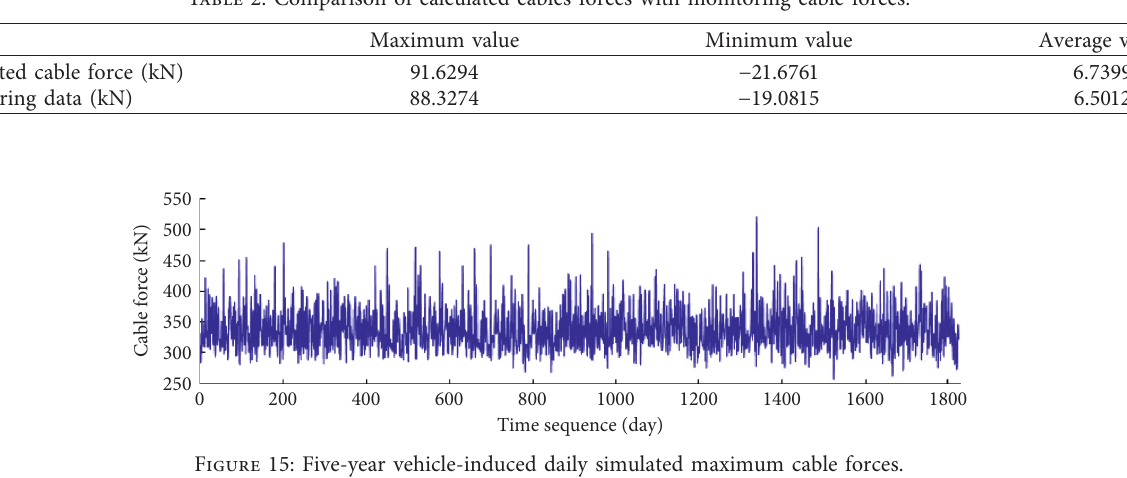
Table 2: Comparison of calculated cables forces with monitoring cable forces.